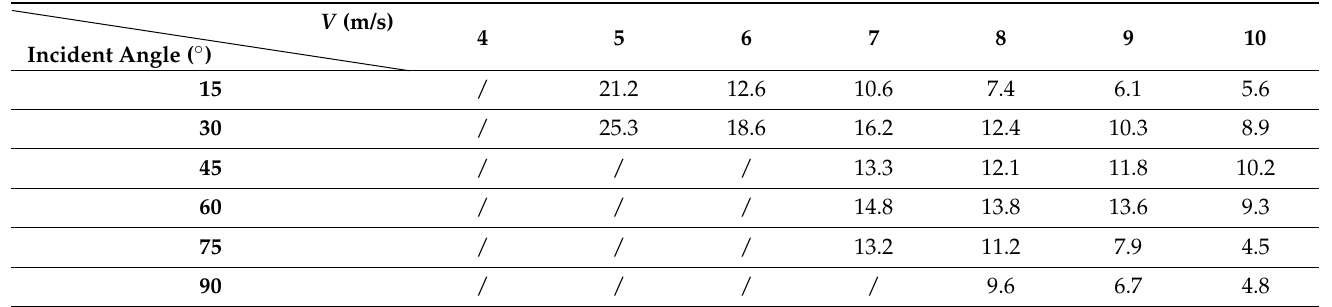
Table 4. Splash timetable for droplets with different incident angles (circular wire)/ μ s.